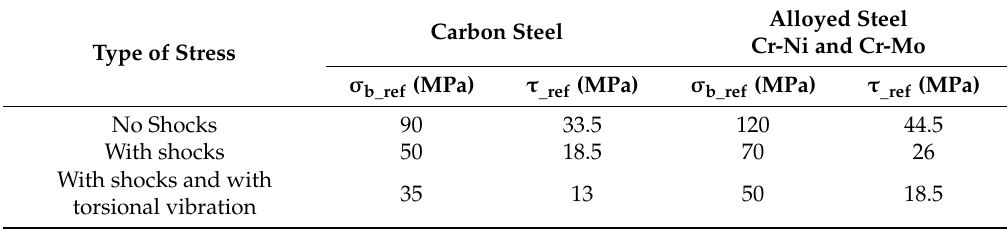
Figure 3. Nomenclature and forces acting on the tooth. Table 1. Allowable stresses ( σ b_ref and τ _ref ) for carbon steel and for alloyed steels for base radius r > 0.3 mm